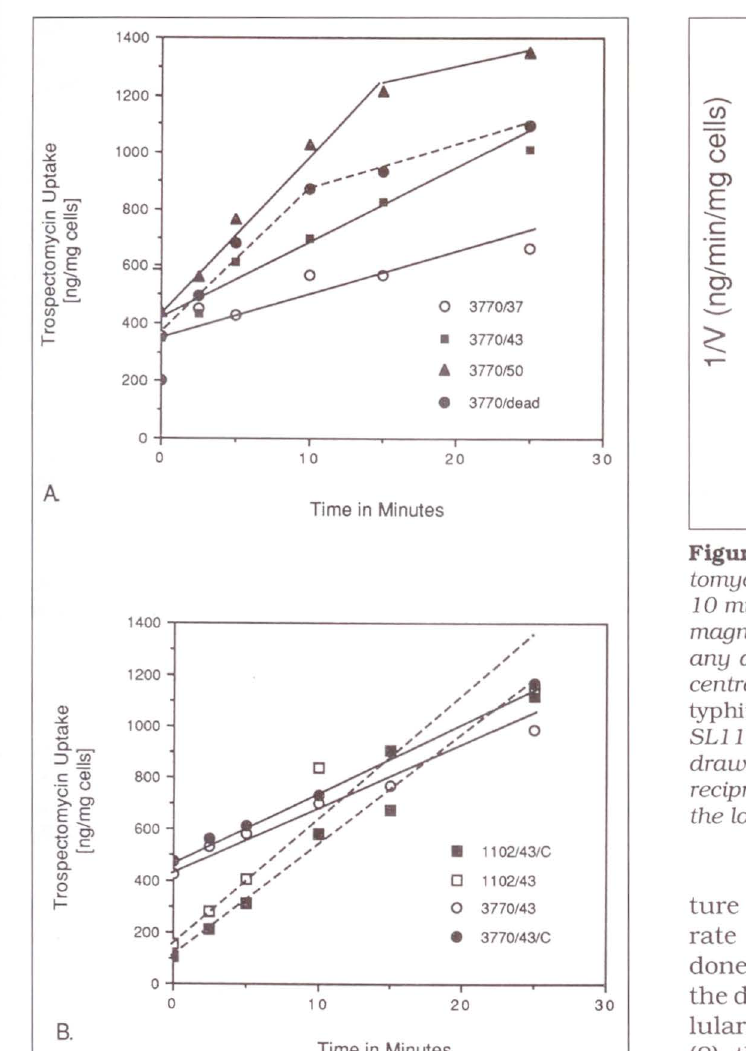
Figure 1) Uptake of trospectomycin at a concentration of 128 IJ.g/mL in nutrient broth of A Salmonella typhimurium LT2 SL3770 at 3flC (open circles}, 43°C (closed squares) and 5ifC (closed triangles) and of heat killed SL3770 at 3flC (closed circles. broken line) and B S typhimurium LT2 SL3770 (circles) and SL11 02 [deep rough] (squares, broken lines) at 4SOC with 40 !J.M car bonyl cyanide m-chlorophenylhydrazone (CCCP) added 2 mins before addition of trospectomycin (closed circles or squares) or without CCCP (open circles or squares)